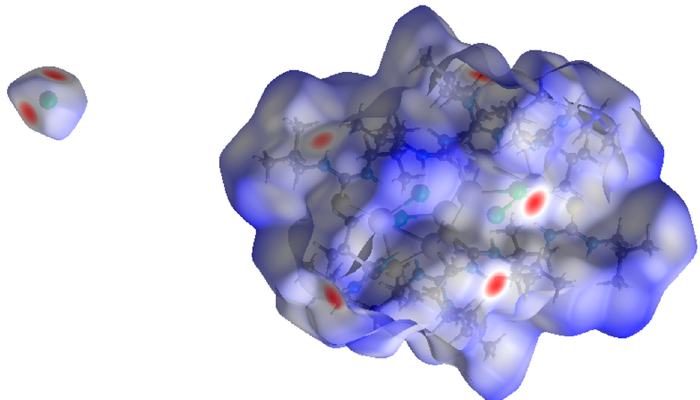
Figure 11. View of the three-dimensional Hirshfeld surface of 3 plotted over d norm in the range − 0.4772 to 2.1283.